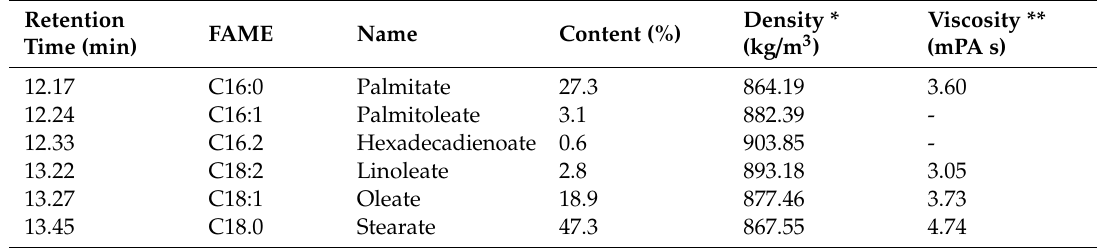
Table 2. FAME characteristics of C16 and C18 FAs in C. subglobosa according to Figure 4.